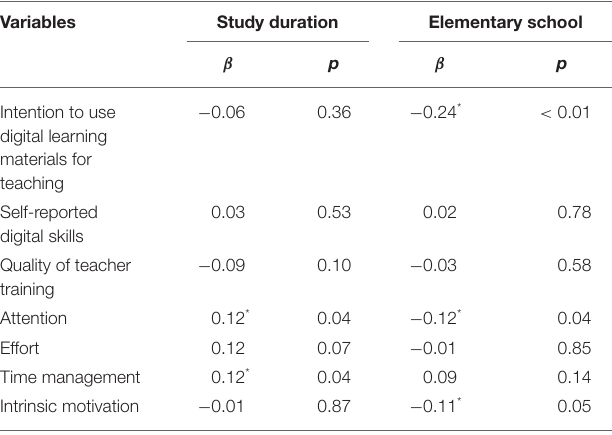
TABLE 3 | Standardized effects for the included control variables study duration and school type (elementary school vs. other).